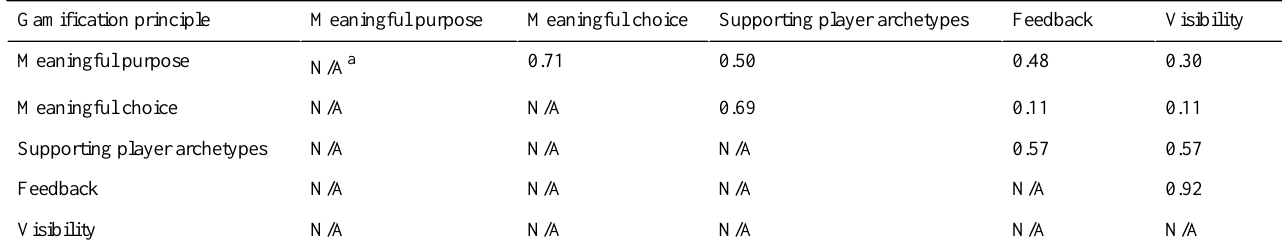
Table 4. Correlation matrix between gamification principles across all rated apps.